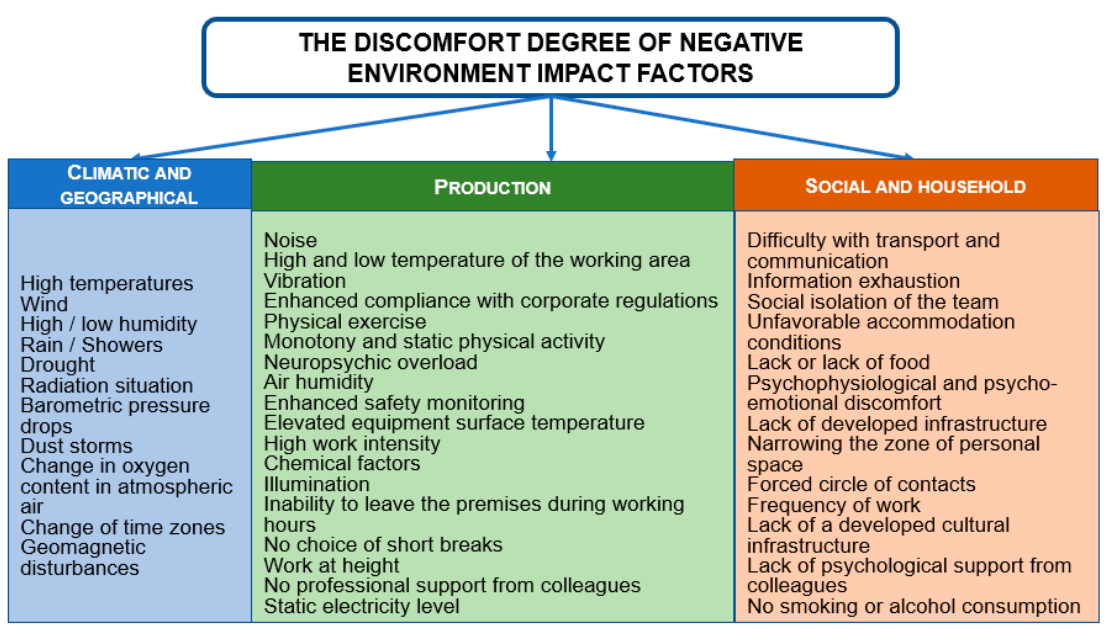
Figure 4. The negative impact of the environment factors lists on the FIFO personnel of industrial enterprises.